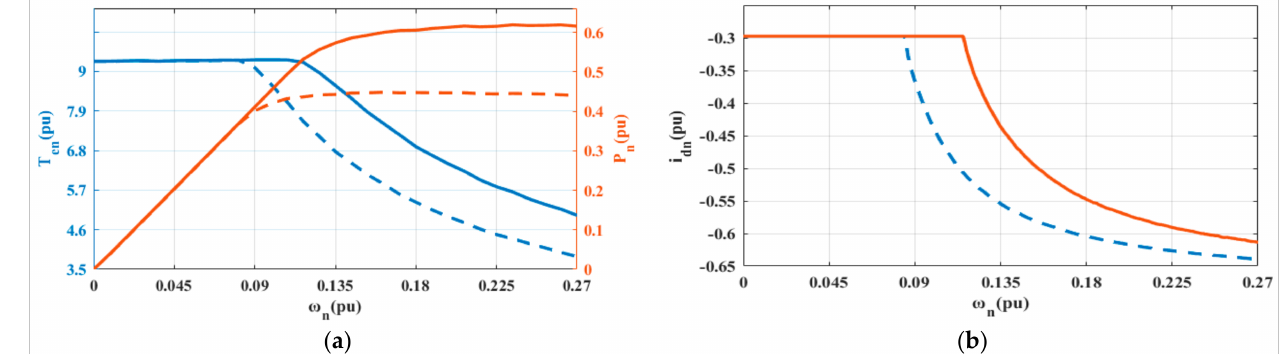
Figure 7. External characteristic curve and negative id current of traditional topology (T1) and motor drive topology with bidirectional DC/DC (T2). ( a ) Torque-velocity curve (blue), power–velocity curve (red) of T1 (virtual line) and T2 (solid line). ( b ) Velocity-negative current id curve of T1 (virtual line) and T2 (solid line).